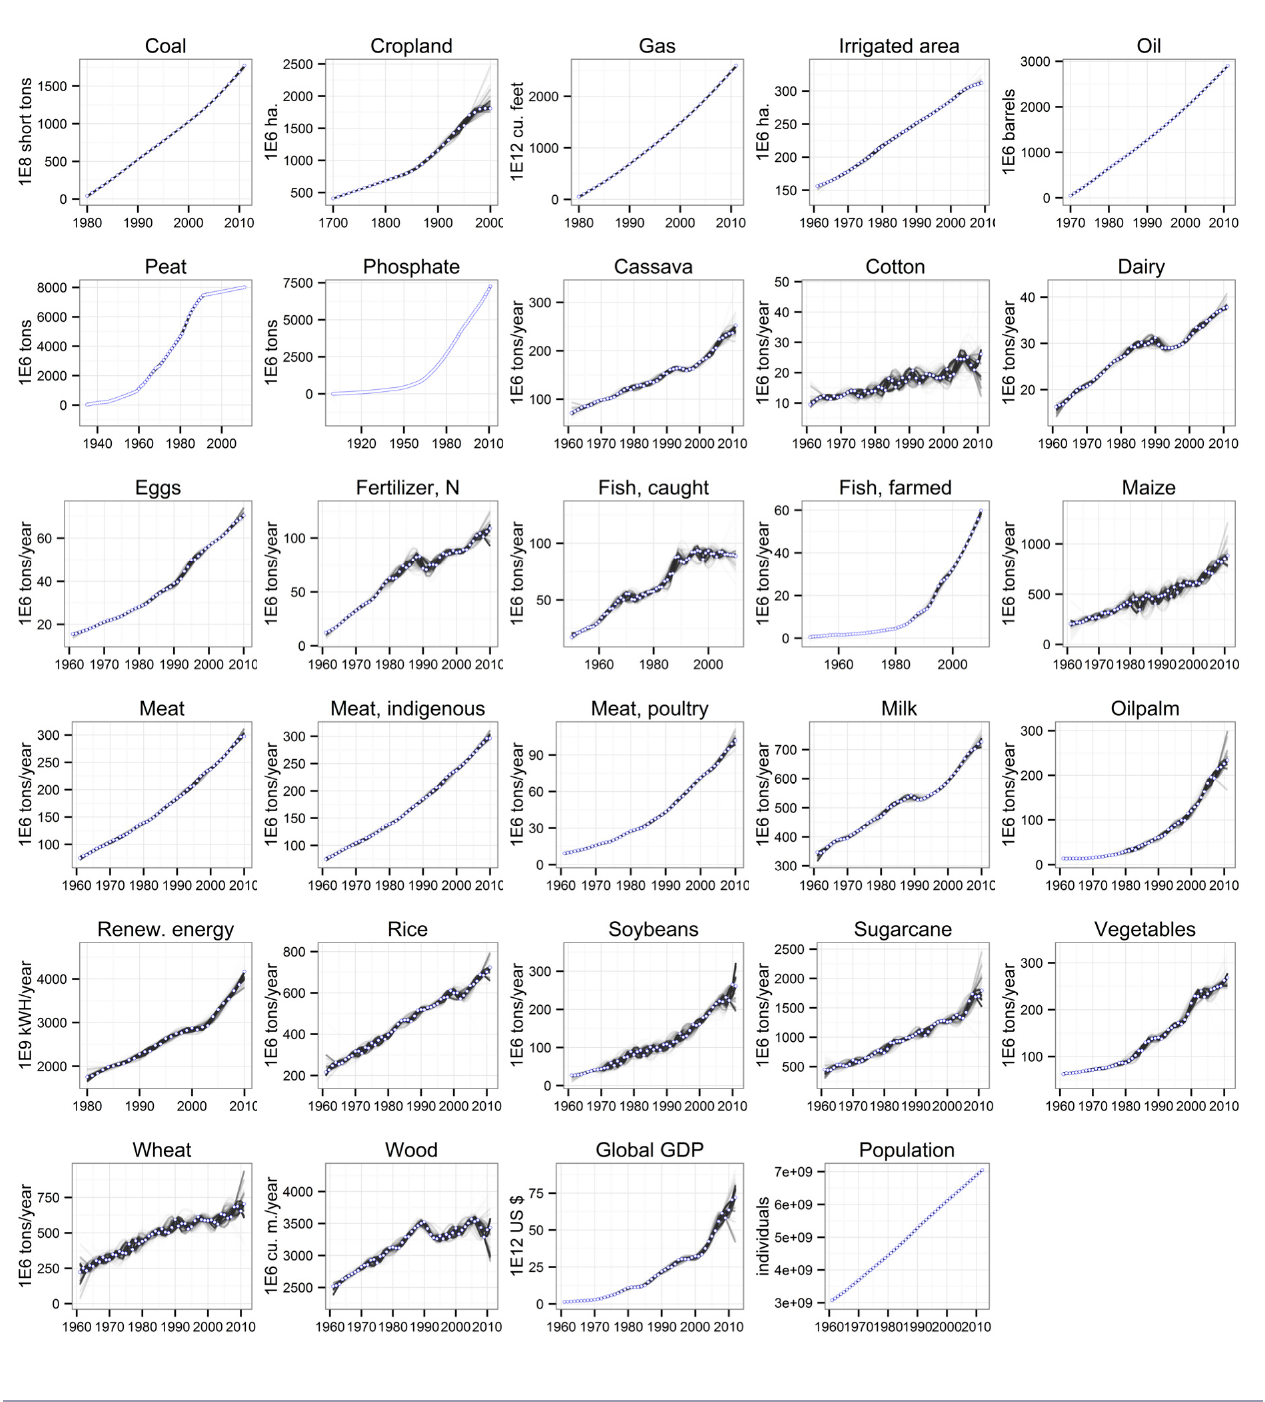
Fig. 2 . For the global resources and drivers, the raw data is plotted as blue points. The nonrenewable resources are accumulated over time for growth rate analysis and for the renewable resources the yearly production is analyzed. The grey to black lines each represent one smoothed time series of the bootstrap resamples (5000). A wider set of lines implies larger uncertainty when estimating peak-rate year, e.g., compare peat vs. wheat. The uncertainty can be so small that the blue points hide the smoothed time series, e.g., population. There are local minima and maxima, which increase the uncertainty, e.g.,